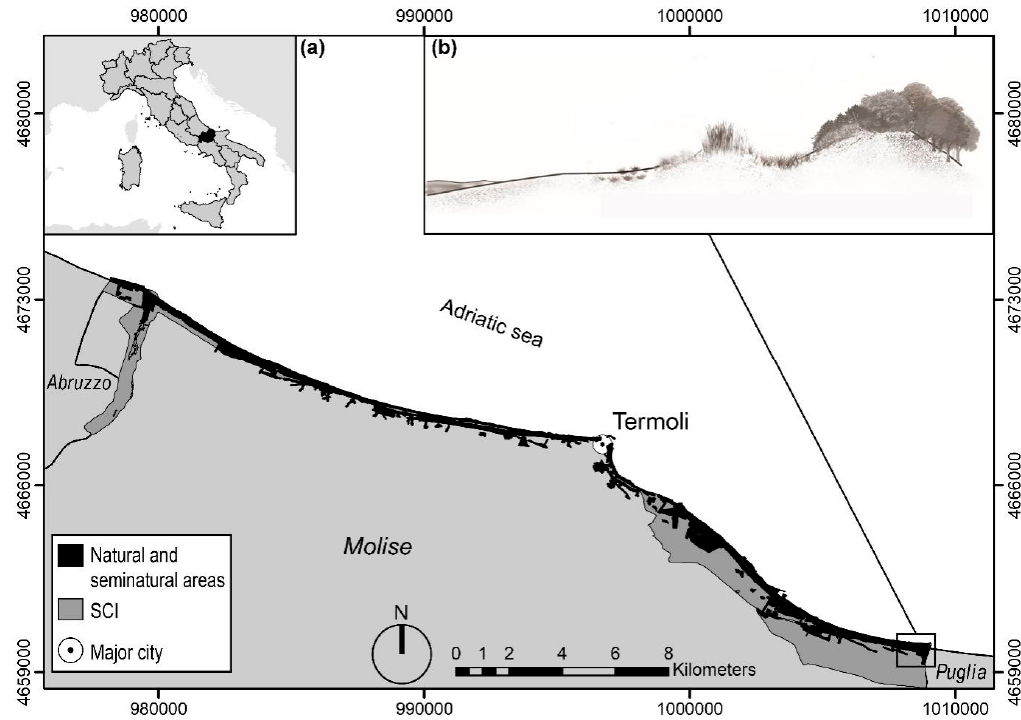
Figure 1. ( a ) In black, the study area including the coastal dunes of the Molise Region (Italy). Most of the analyzed coastal sectors are included in Sites of European Conservation Concern (SCI, European Directive 92/43/EEC): Foce Trigno-Marina di Petacciato (IT7228221); Foce Biferno-Litorale di LTER network [40,42]. ( b ) An example of coastal zonation. Reference system WGS84 UTM32 (epsg: